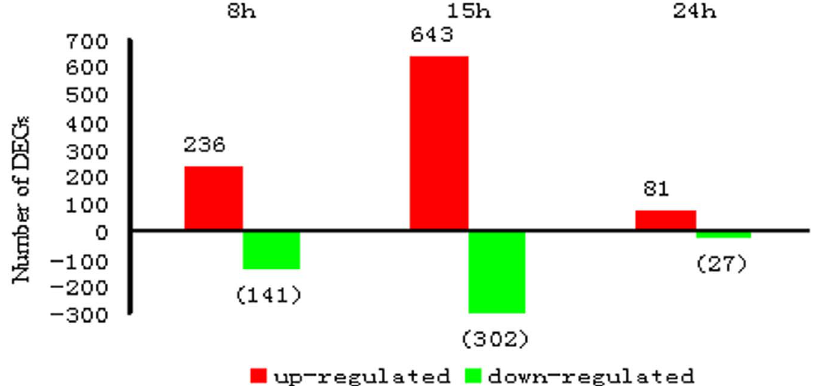
Figure 2. Differentially Expressed Genes in three time points. doi:10.1371/journal.pone.0091189.g002 PLOS ONE |